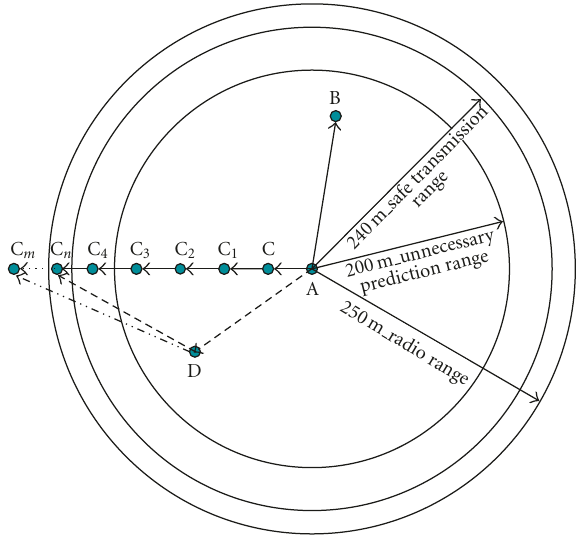
Figure 9: Preemptive mechanism and various